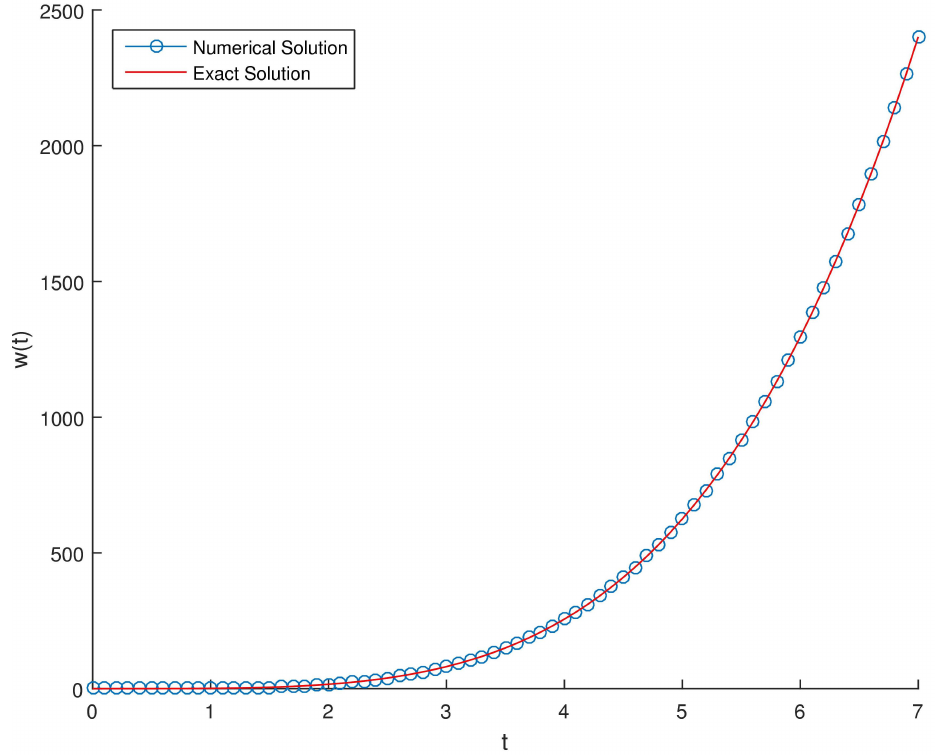
Figure 15. The compared results of the approximate and exact solutions for Example 5 where t ∈ [ 0,7 ]